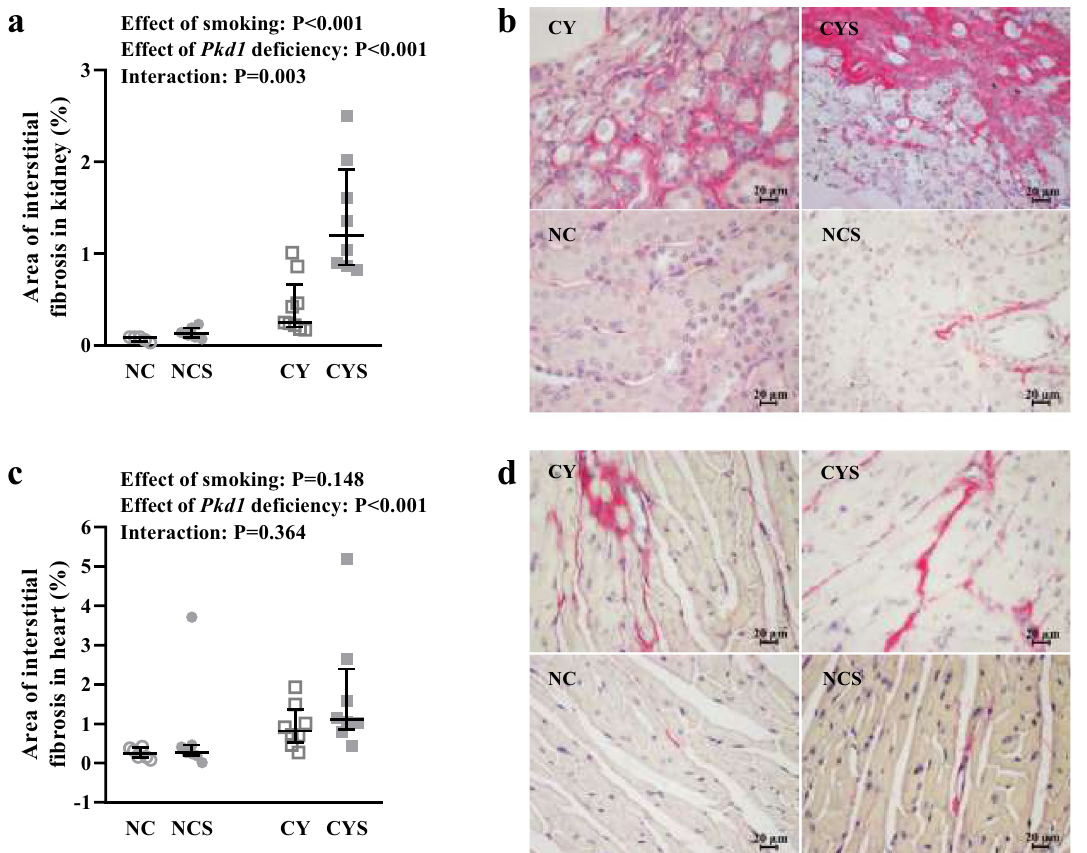
Figure 6. Analyses of the effects of smoking and Pkd1 deficiency in renal ( a ) and cardiac ( c ) fibrosis index on NC (n = 5), NCS (n = 9), CY (n = 7) and CYS (n = 8) mice. These data were analyzed using aligned rank transform followed by two-way analysis of variance. b ) Representative images of renal fibrosis and d ) Representative images of cardiac fibrosis in the four groups. Original magnification × 400; bar = 20